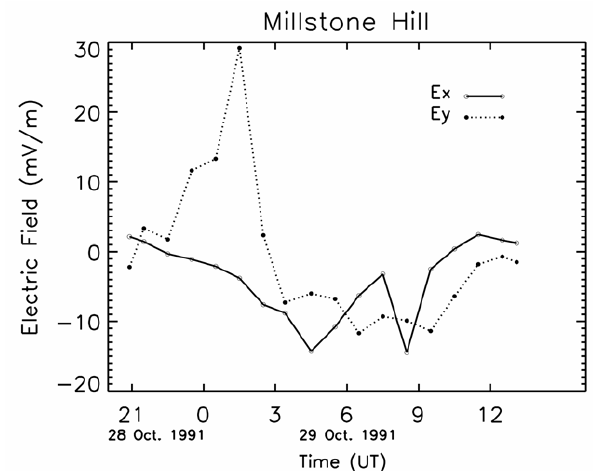
Fig. 8. Plasma drift observations converted to electric fields (mV/m) Figure 8. Plasma drift observations converted to electric fields (mV/m) at Millstone at Millstone Hill on the night of 28–29 October 1991, with 10m/s Hill on the night of 28-29 October 1991, with 10m/s corresponding to 1mv/m. corresponding to 1mv/m. Separate north (y) and east (x) electric fields are